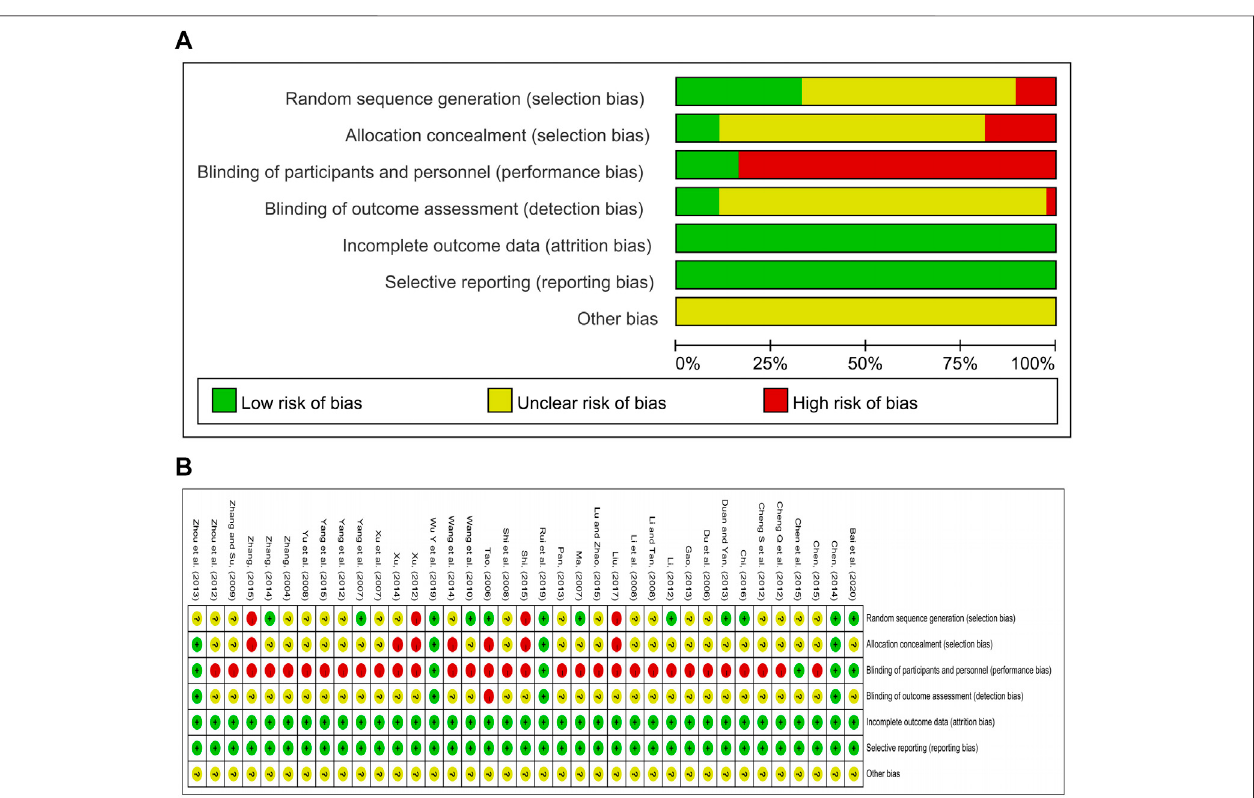
FIGURE 2 | Risk of bias graph (A) and risk of bias summary (B) , respectively.